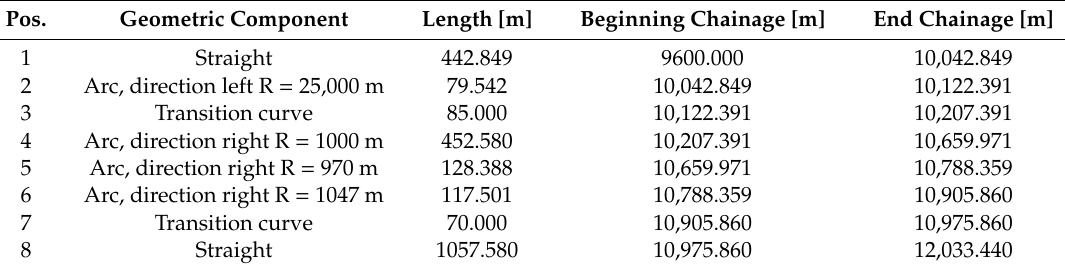
Table 1. Geometric layout of the analyzed section of the railway